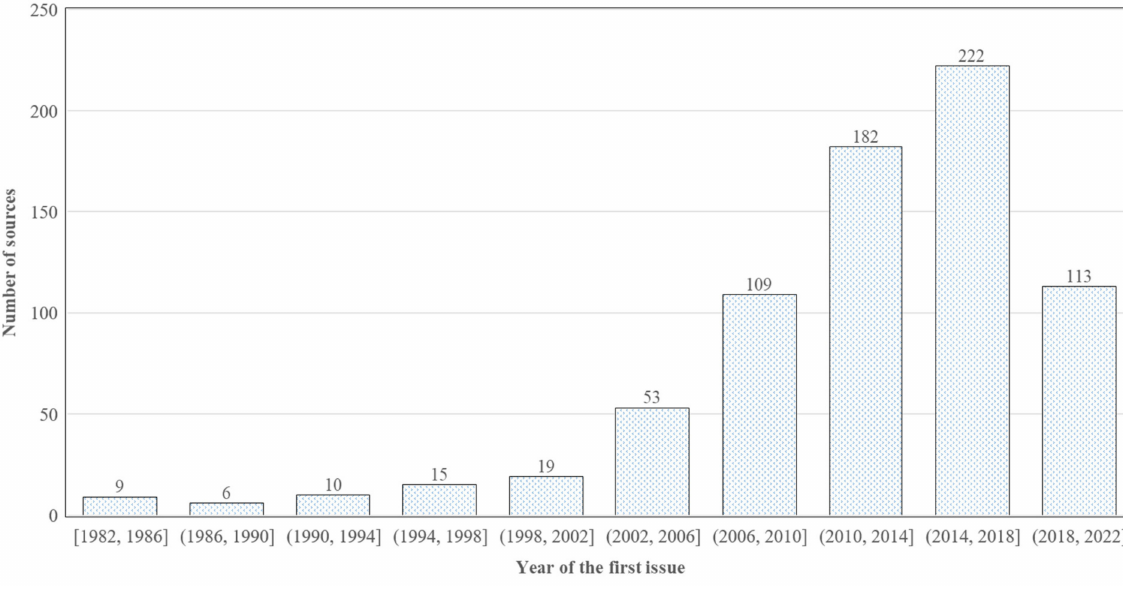
Figure A2. Distribution of sources over time with their first issue